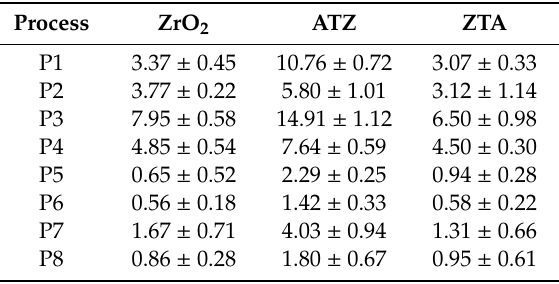
Table A2. Mean forces, F (N), in the grinding processes per